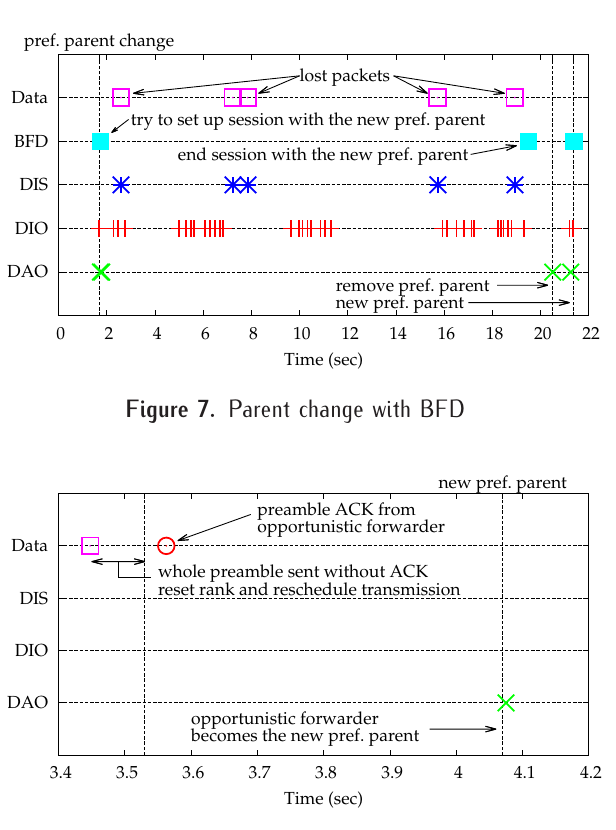
Figure 8. Parent change with MT-RPL